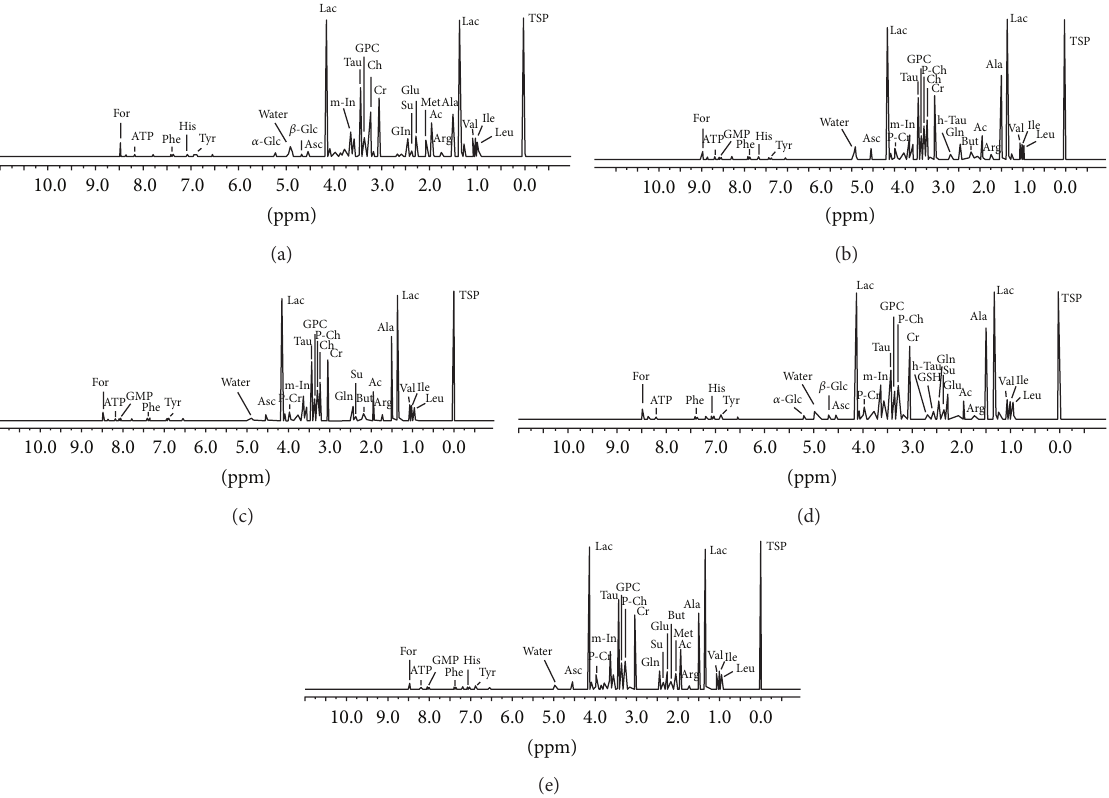
Figure 1: Representative HR MAS 1 H NMR spectra of the intact human eye tissues. (a) cornea, (b) ciliary body, (c) iris, (d) lens, and (e)